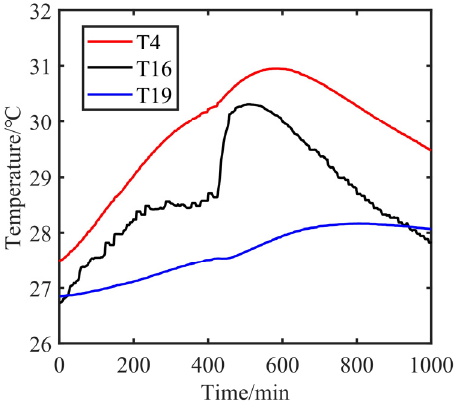
Figure 6. Temperature data of the selected key points for the second machine tool.